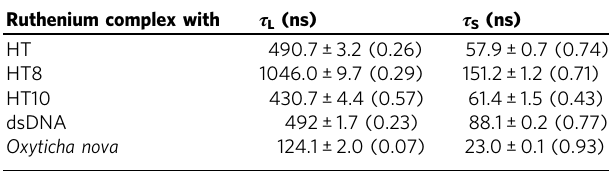
Table 1 The 3 MLCT luminescence lifetimes of [Ru (phen) 2 dppz] 2 + in DNA, obtained from bi-exponential fi tting, with preexponential factors for the two lifetime components shown in parentheses.